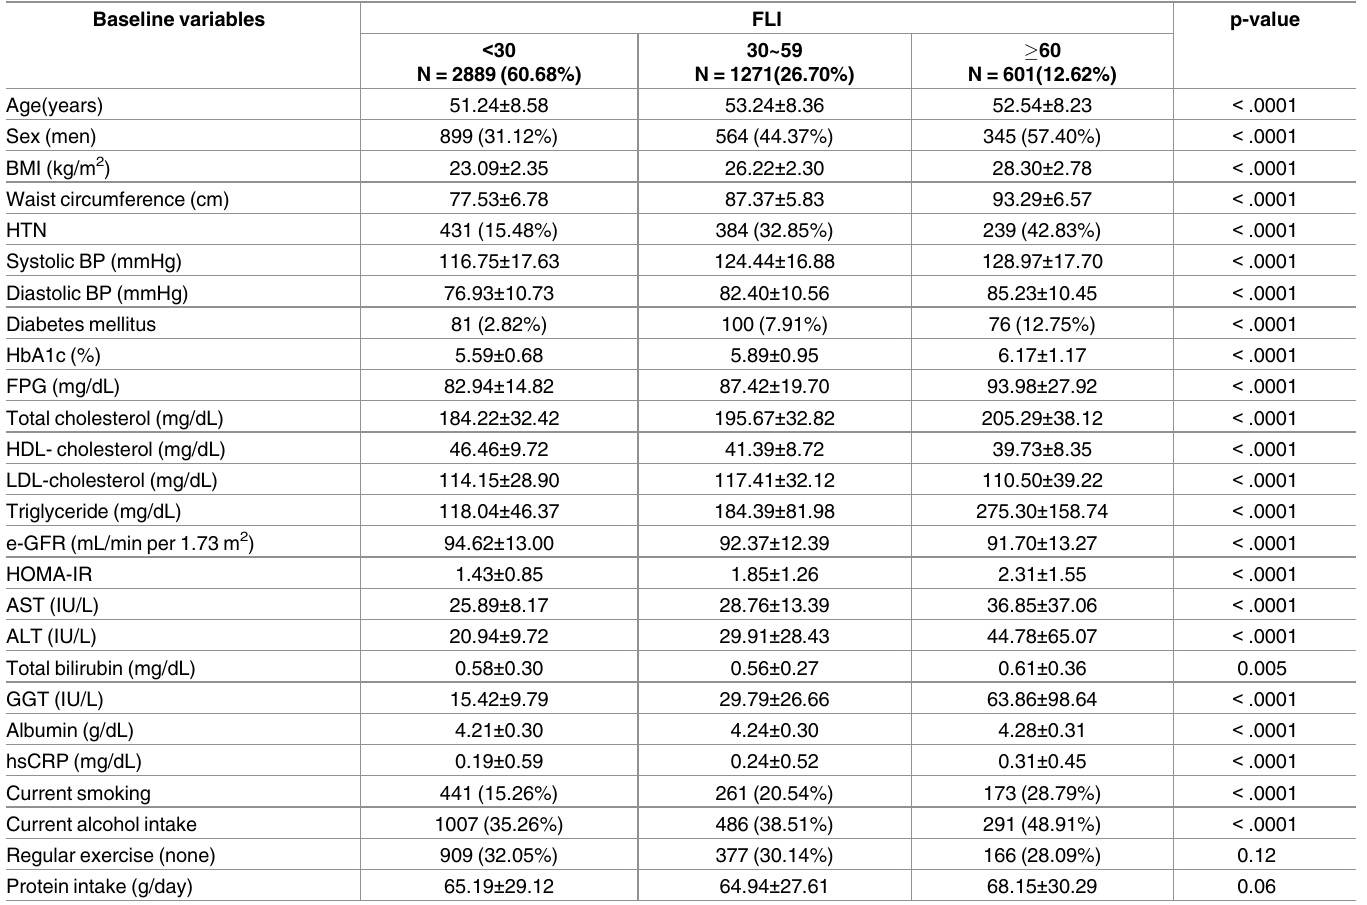
Table 2. Baseline characteristics according to FLI category.